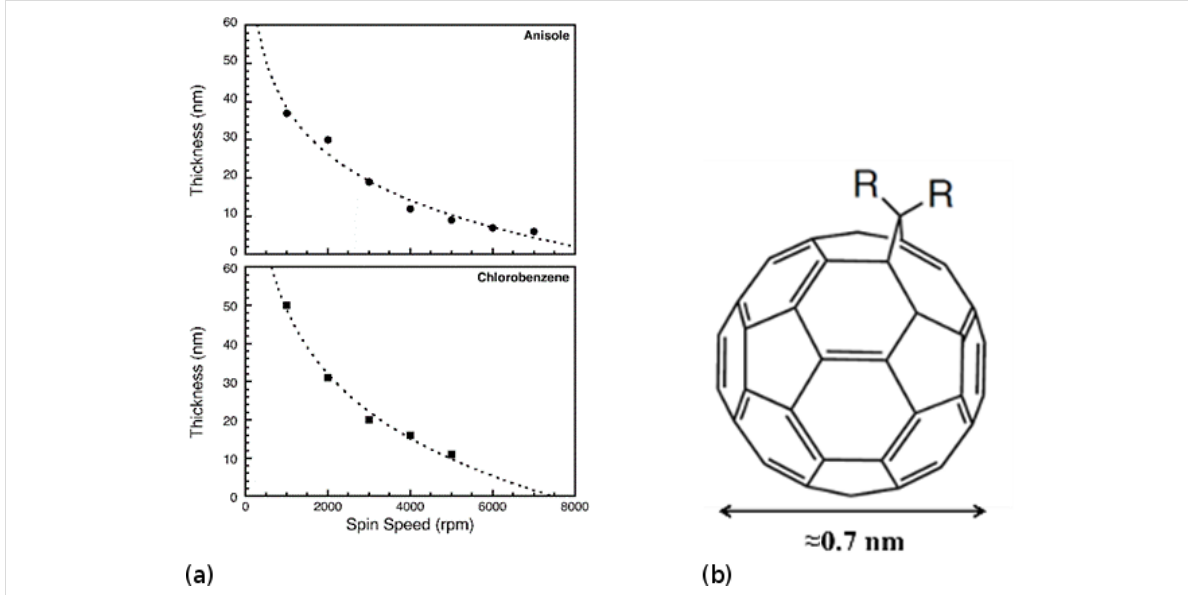
Figure 4: (a) Spin-coating results for fullerene resists HM-01A and HM-01C using anisole and chlorobenzene solvents, respectively. (b) Schematic of the monoadduct methanofullerene molecule used in the HM resist series [40].